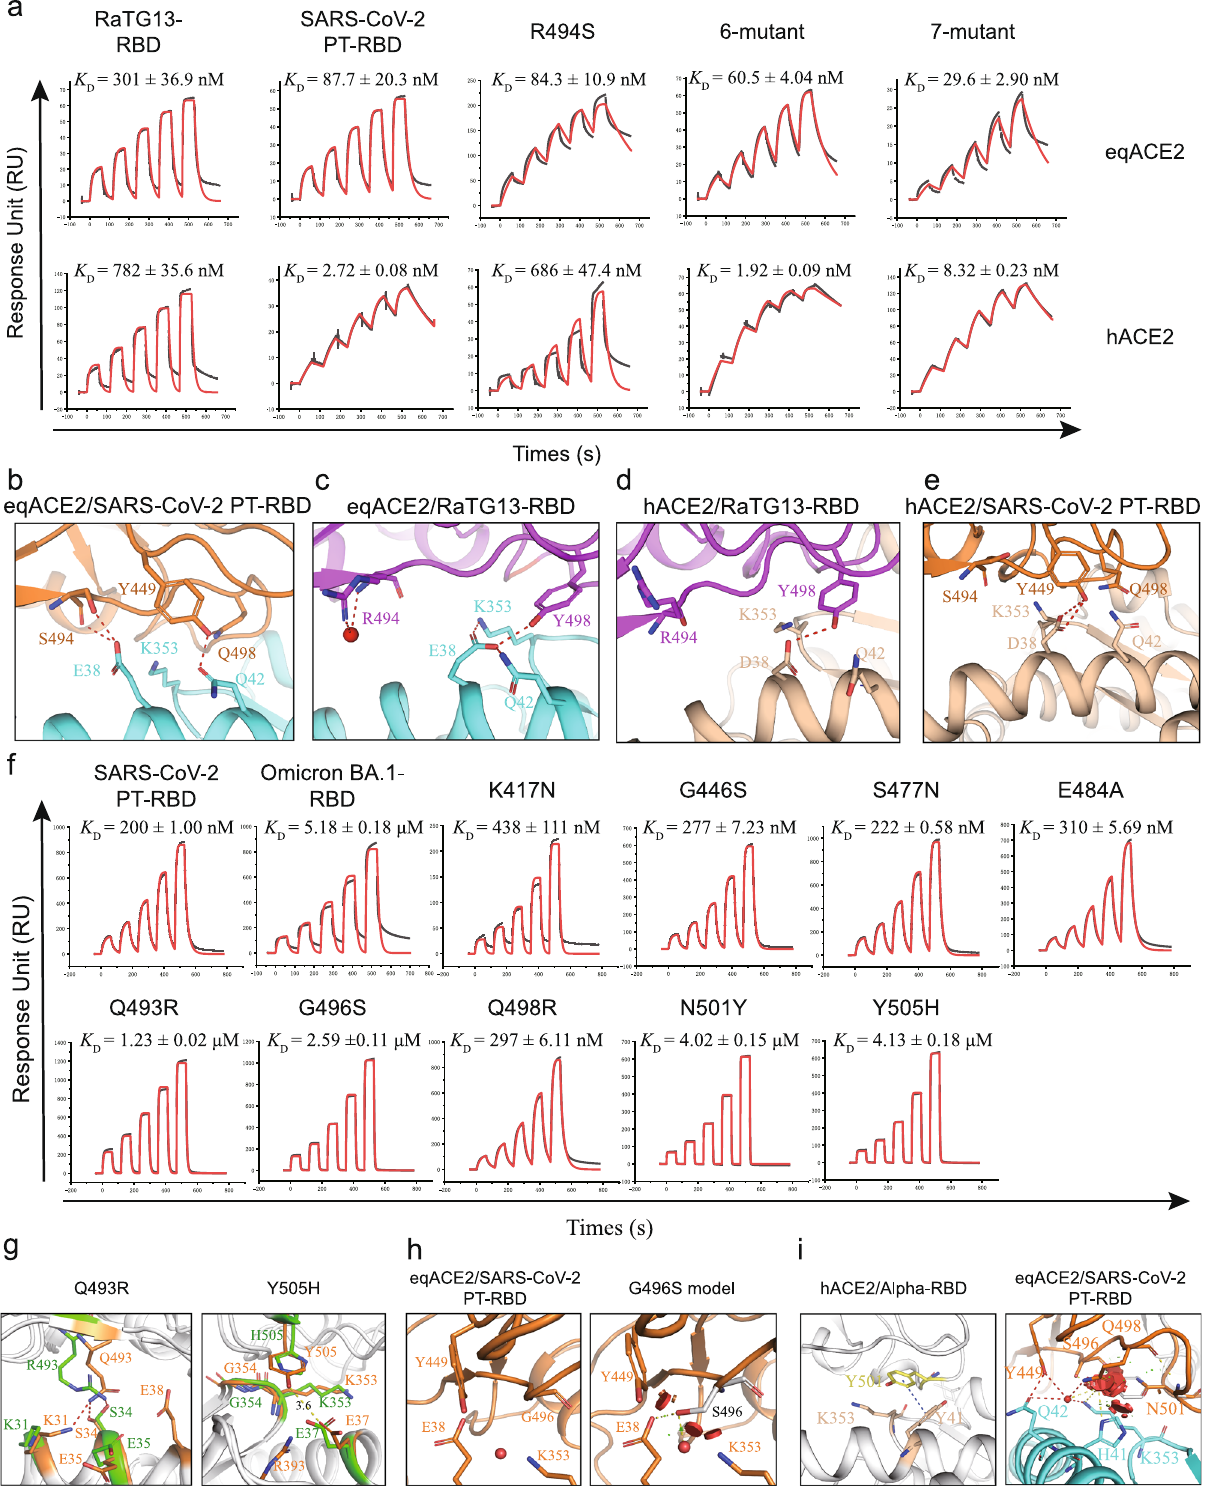
Cross-reactive immunity of the SARS-COV-2 PT-RBD to the RaTG13-RBD . Our previous work indicates that a cross-reactive immune response of SARS-CoV-2 to RaTG13 exists in humans 21,46,47 . To assess whether a similar circumstance applies to horses, we performed fl ow cytometry to examine whether a monoclonal antibody can block recognition between eqACE2 and